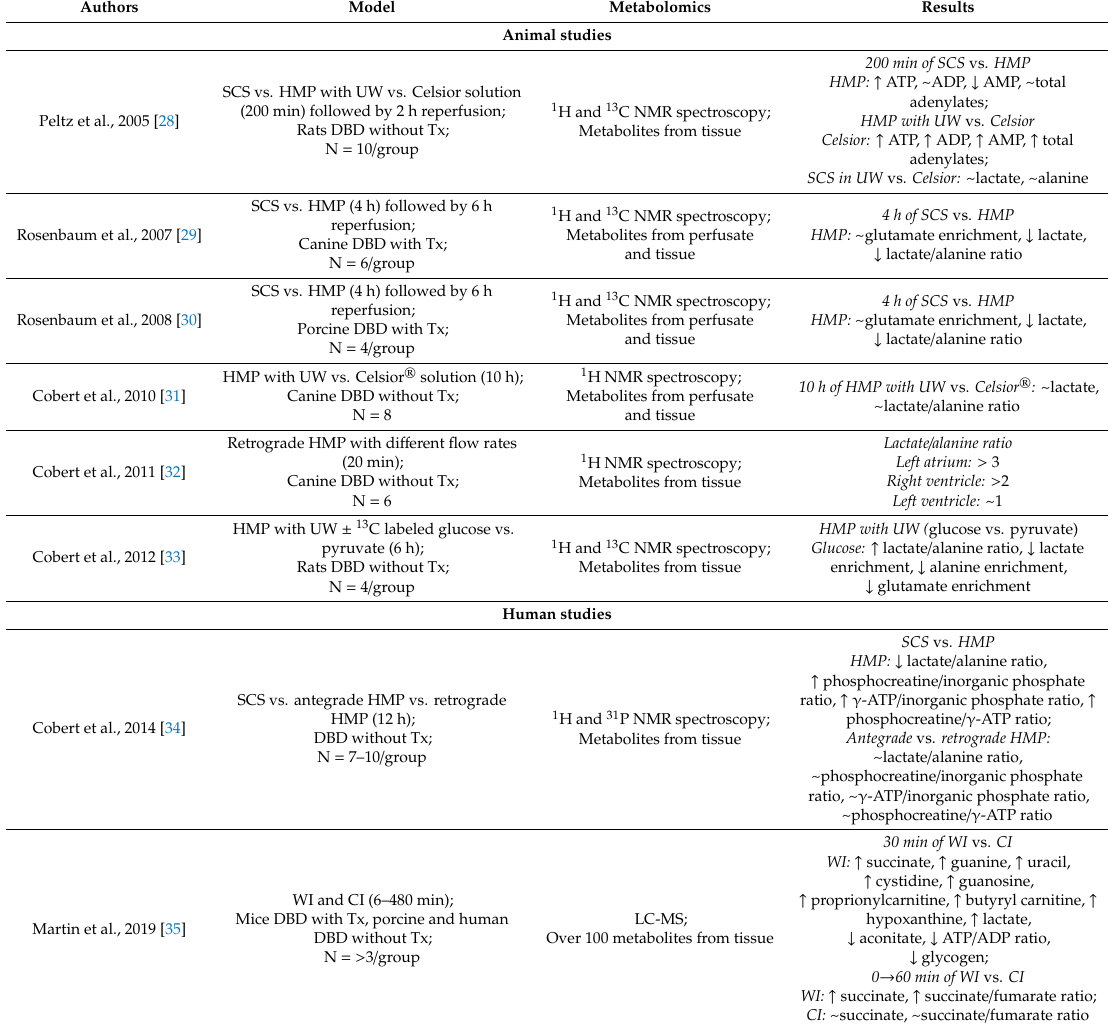
Table 1. Metabolomics in heart preservation for